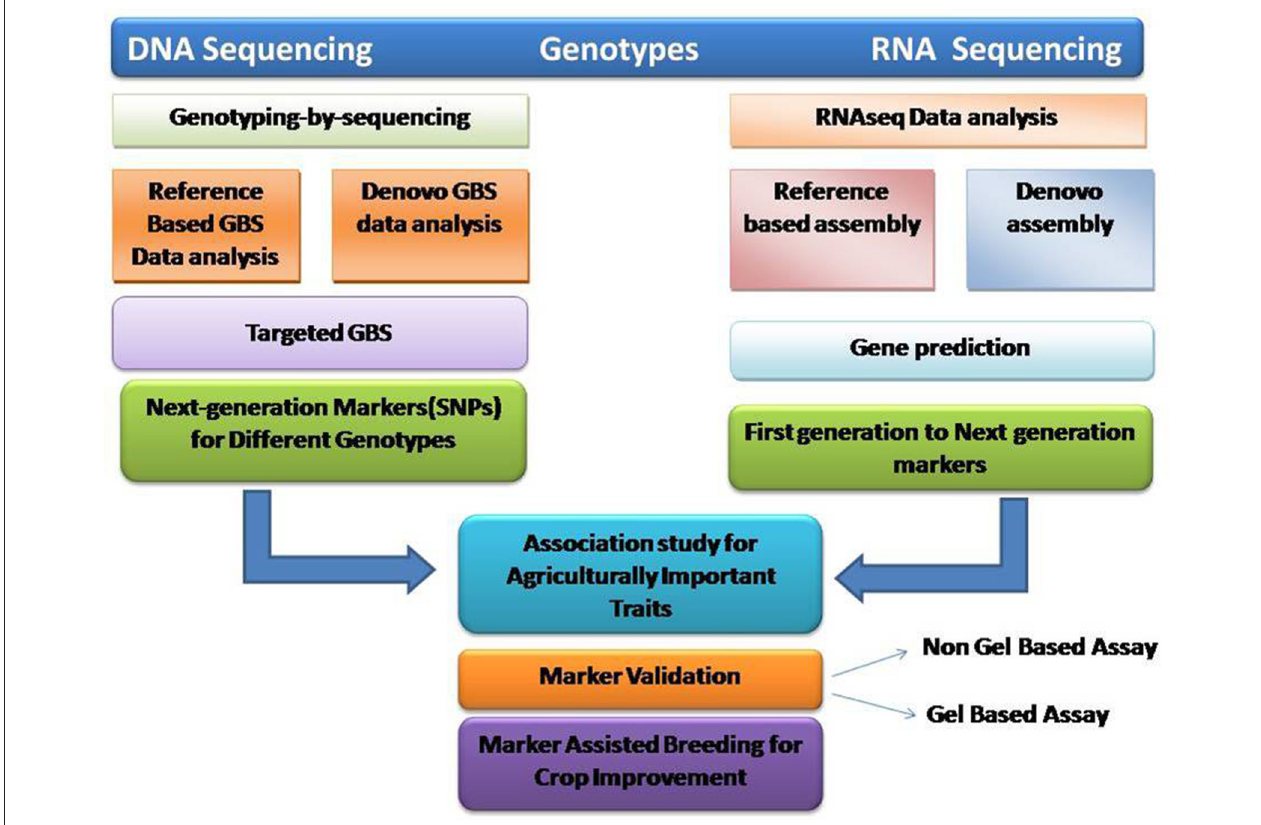
FIGURE 1 | Use of next generation sequencing technologies based on RNA sequence data and genotype by sequencing for marker discovery.